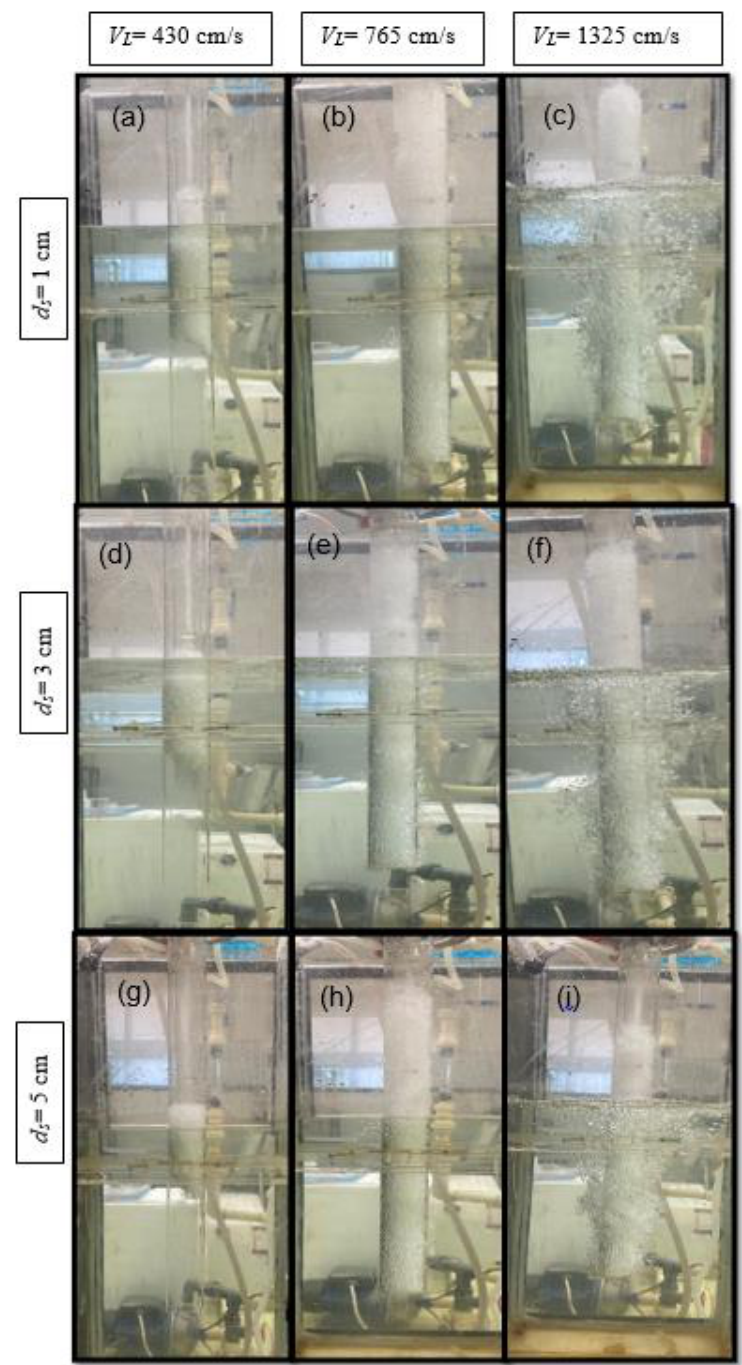
Figure 15. H p and H R levels in a downcomer of l ADR = 37 cm and d s = 1 cm ( a – c ); d s = 3 ( d – f ); and d s = 5 ( g – i ).